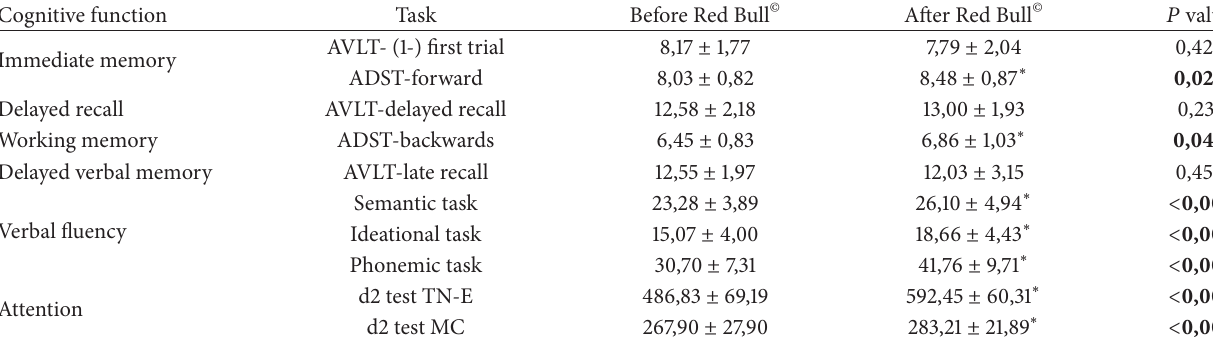
Table 2: Scores achieved on tested cognitive